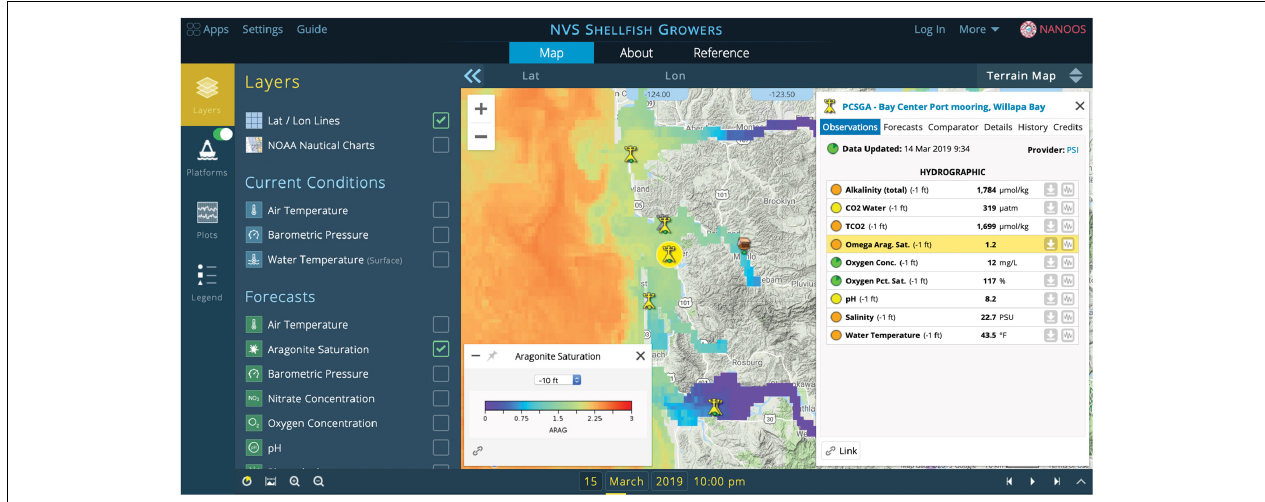
FIGURE 9 | Screenshot of the NANOOS Visualization System “Shellfish Growers” web app. From this page, users can view both forecast model output and near real-time observations. Also added was the ability to view different timescales of the measurements (e.g., oxygen, pH, and salinity) to see how these may co-vary with time. The user selects the units, timescale, and other variables. Other user-selected tabs provide additional details, history, credits, and links to the data provider. Image courtesy of NANOOS; background color image is from a LiveOcean forecast of aragonite saturation